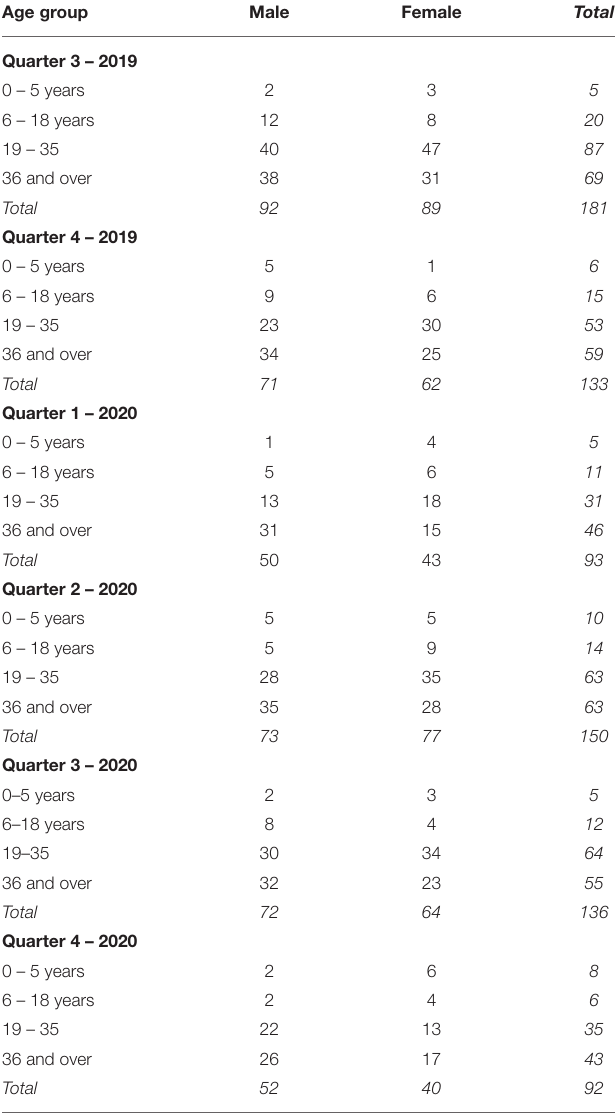
TABLE 3 | Tuberculosis project beneficiaries’ age and gender disaggregated information by quarter in Northwest